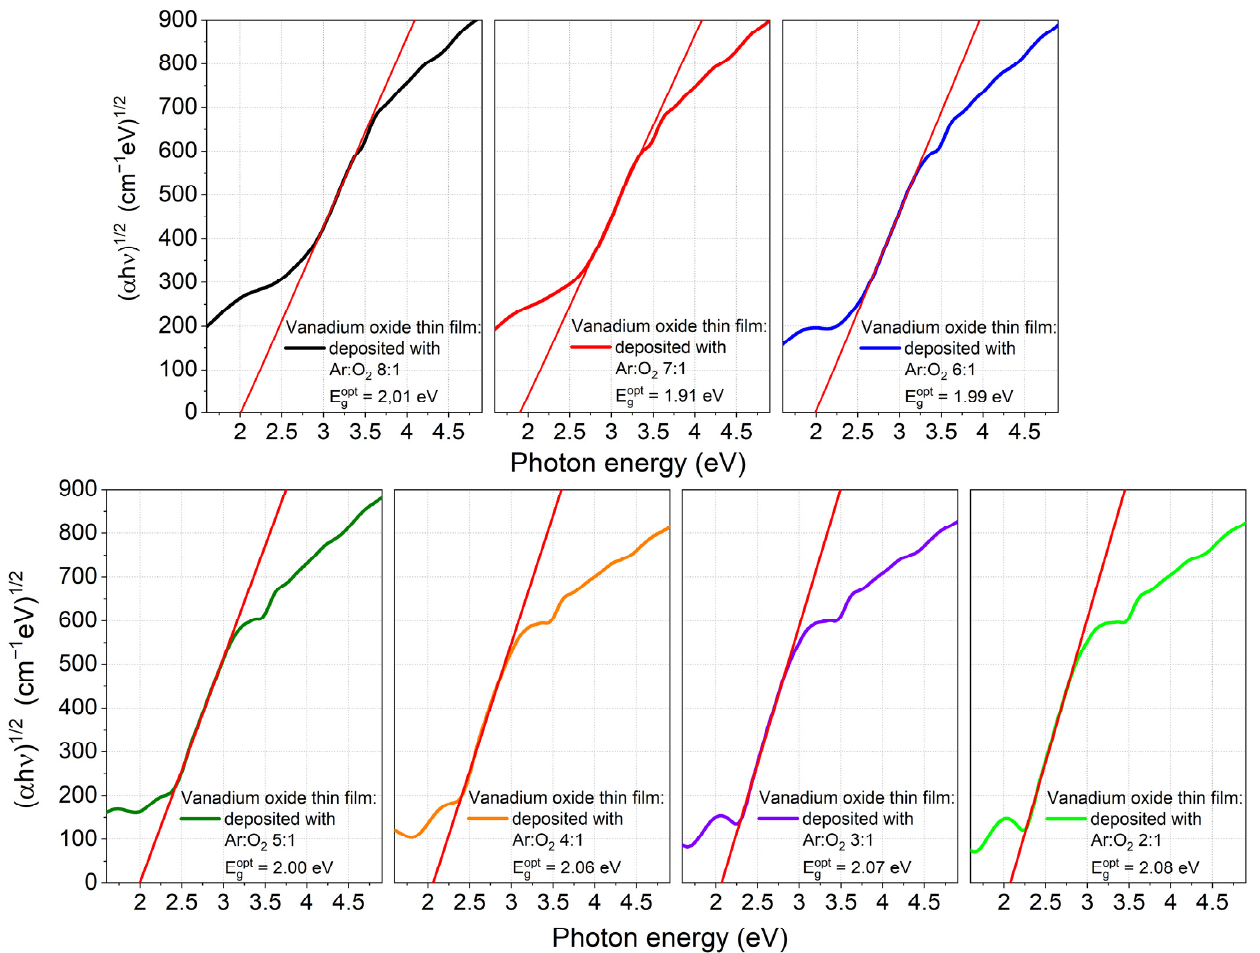
Figure 6. The fundamental absorption edge of as-deposited vanadium oxide thin films.